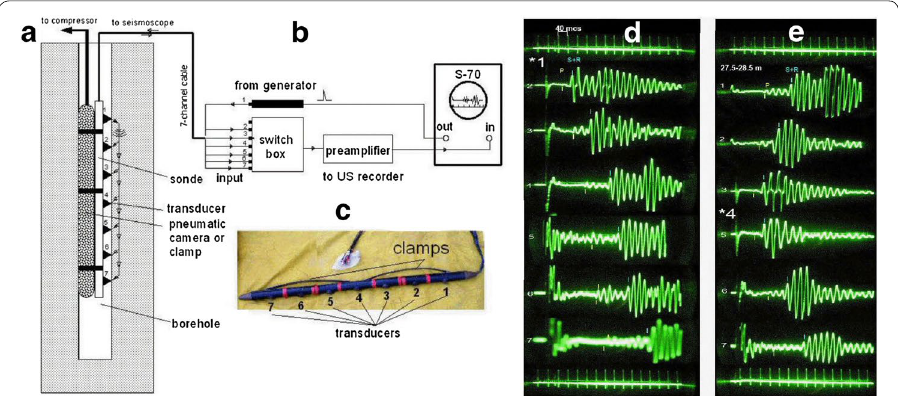
Fig. 6 Borehole logging lay-outs. a Ultrasonic logging: 7-transducer probe within the boreholes; b com- munication schema; c probe photography; d , e Ultrasonic records obtained during ultrasonic logging in the borehole (digits denote numbers of transducers): d 1st transducer is transmitter; 2nd–7th transducers are receivers (direct shot); e 4th transducer is transmitter, the 1st–3rd and 5th–7th ones are receivers (split shot). P and S R (interference shear and surface waves) arrivals are marked by yellow and white , +